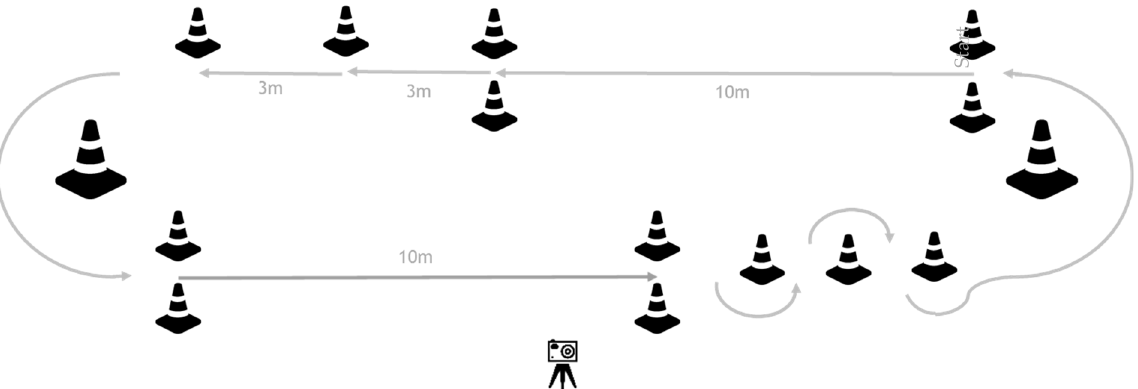
Figure 1. Gait capacity testing circuit. Participants were instructed to perform two laps of the circuit. In this way, they performed 12 subtasks during each circuit, including: four 10mWTs, four 3-m walks, two 180-degree curves, and two slaloms, including a 180-degree curve. After each subtask, participants had to stand still for at least 2 s before starting the next subtask.